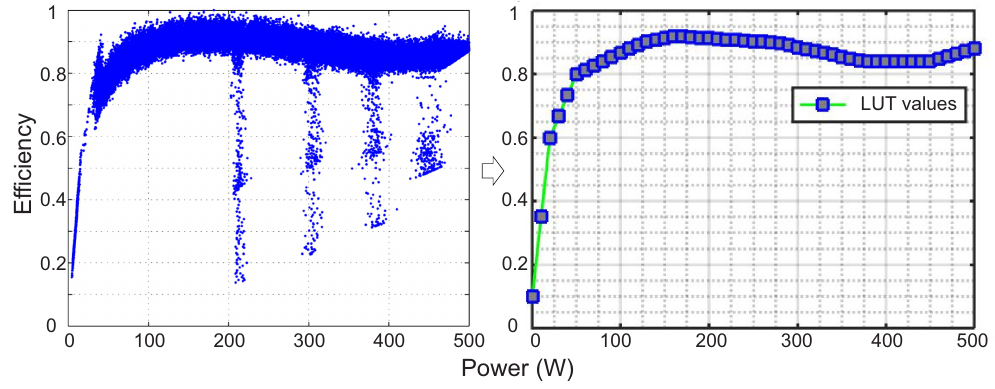
Figure 4. Extrapolation of power-efficiency